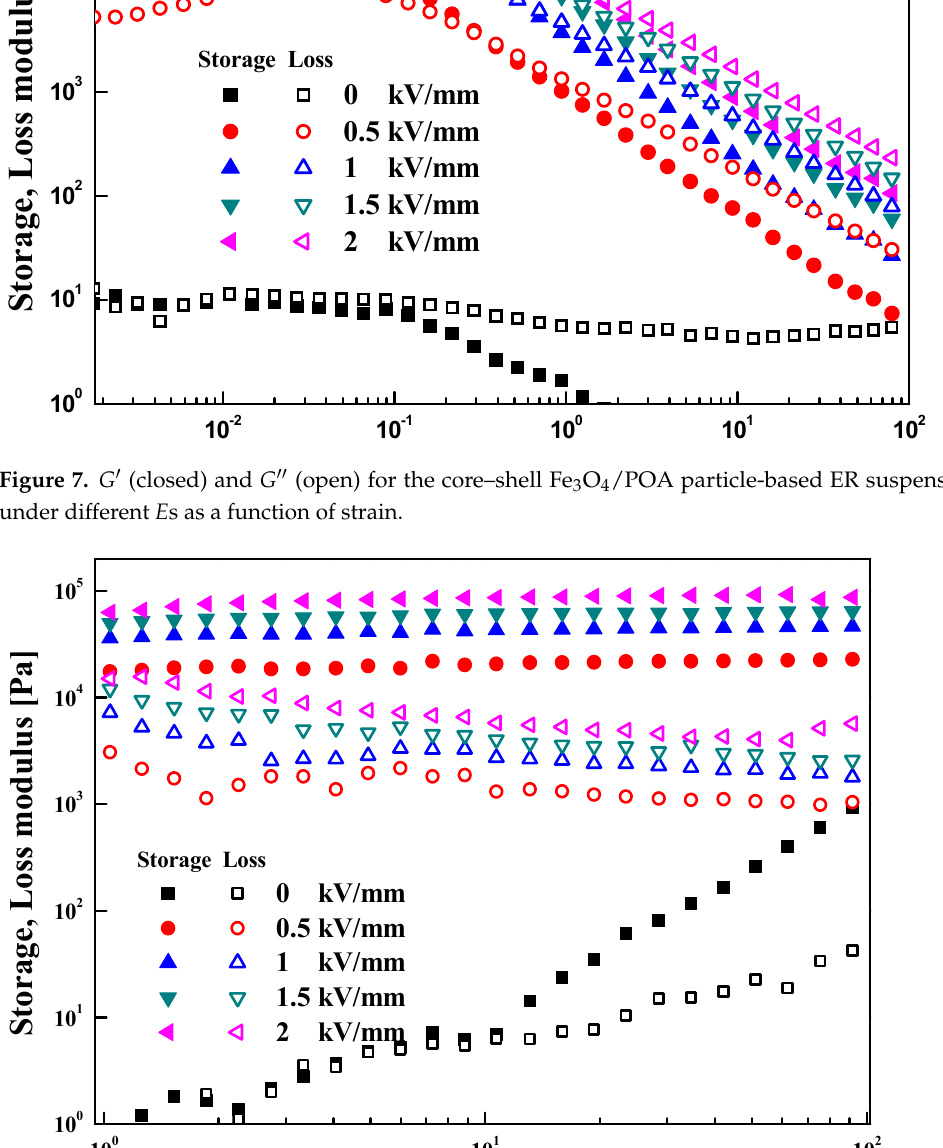
Figure 9. Elastic stress of the core–shell Fe 3 O 4 /POA particle (10 vol%)-based ER suspension as a function of strain. Figure 10 demonstrates the time-dependent relaxation shear modulus, G(t) , of the Fe 3 O 4 /POA-based ER suspension determined from its G ′ and G ″ as a function of frequency